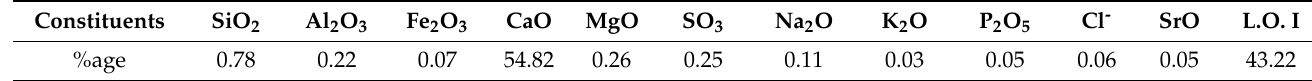
Table 2. Chemical characteristics of marble dust.